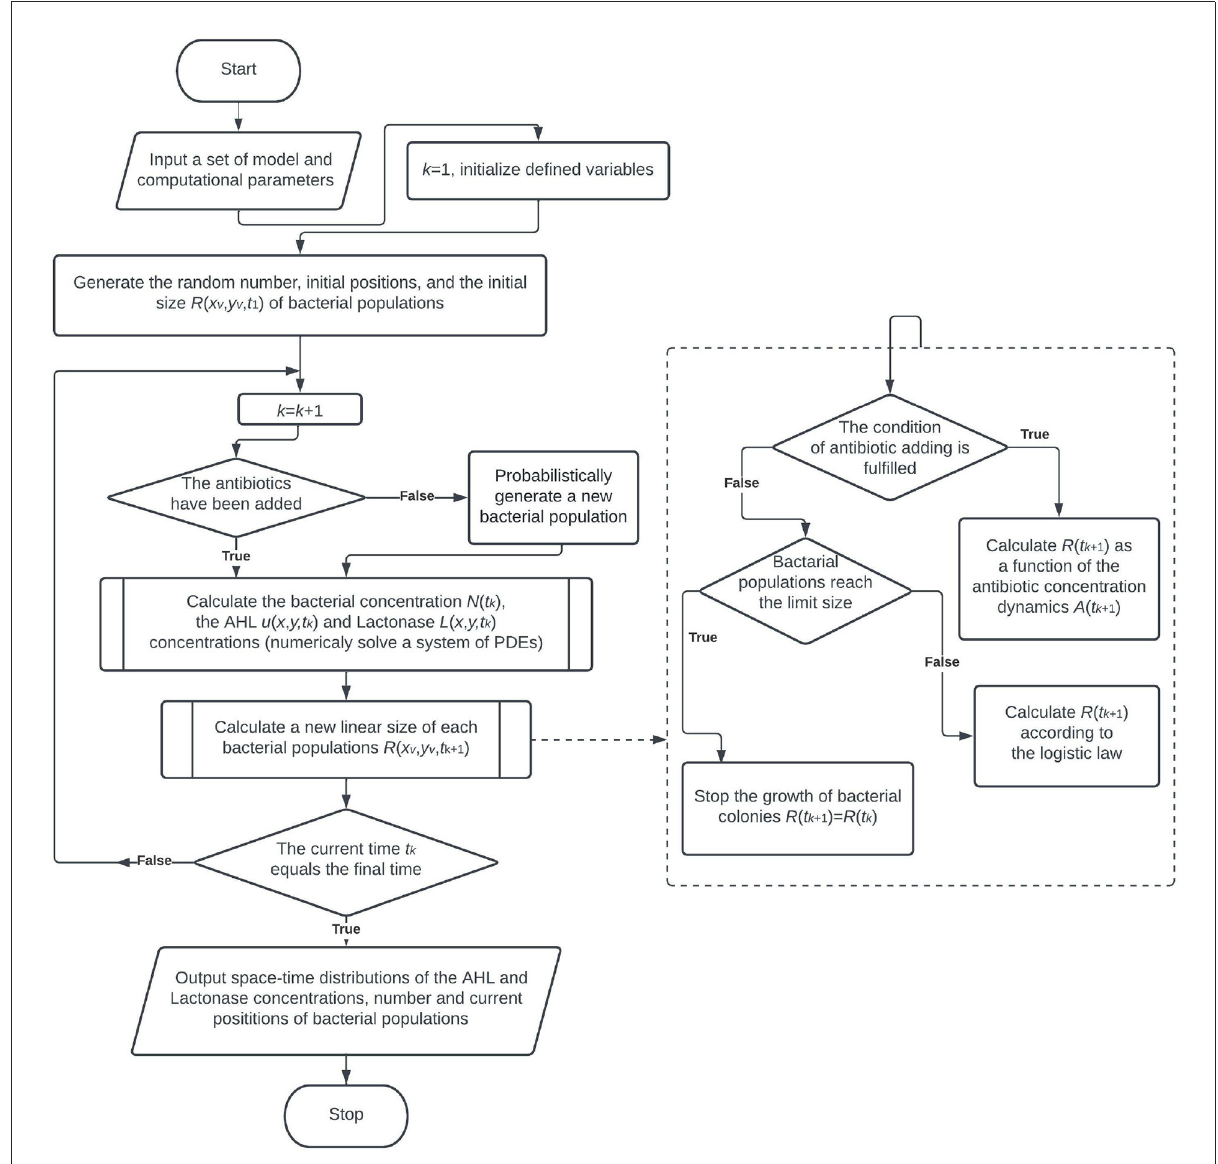
FIGURE1 The flowchart of the general algorithm.